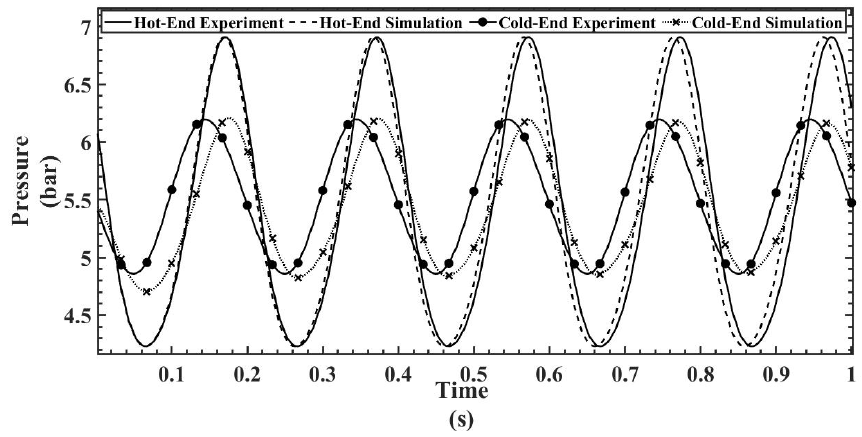
Figure 15. Hot- and cold-section pressure characteristics of a 200 mesh regenerator at 300 RPM.